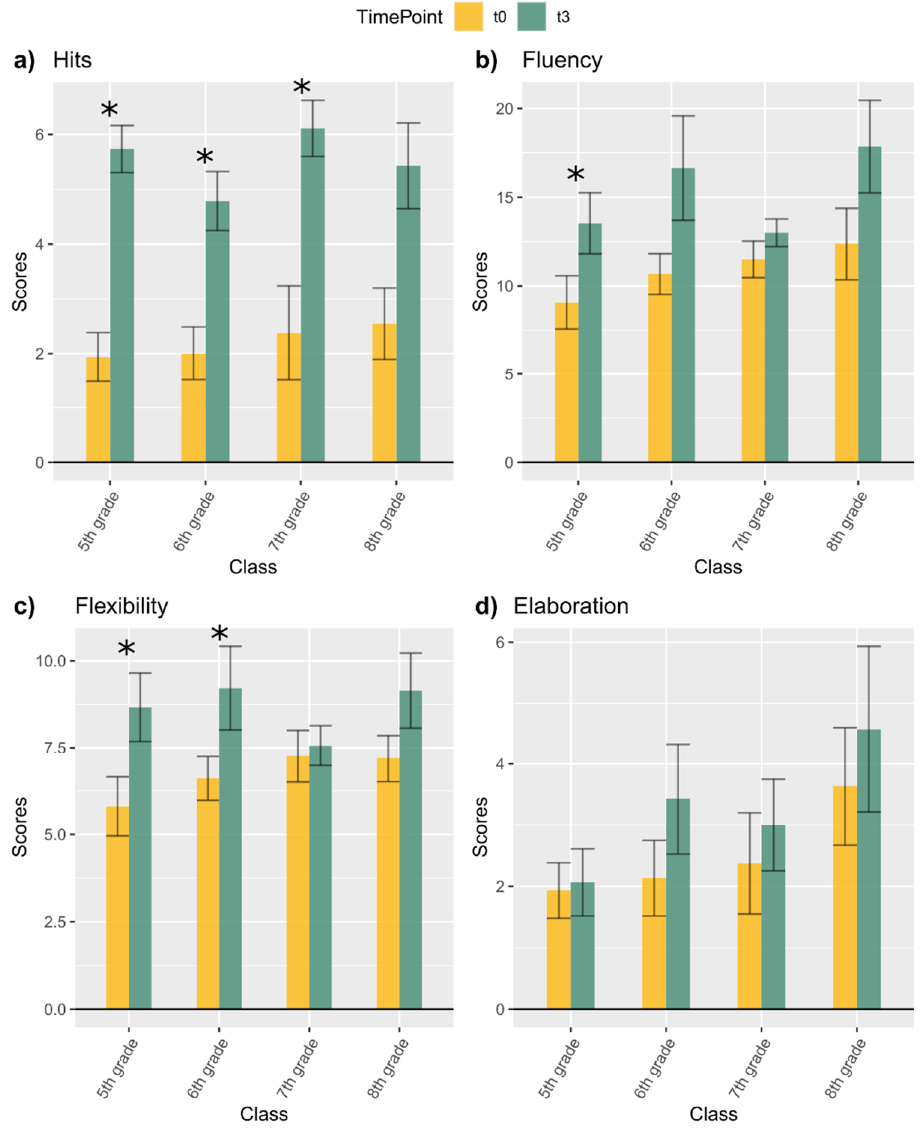
Figure 4. Comparisons between the baseline of the first training (t0) and the baseline before the second training (t3) for ( a ) Hits in HFT; ( b ) Fluency in AUT; ( c ) Flexibility in AUT; ( d ) Elaboration in AUT. Significance levels: * = p < 0.0125 (Bonferroni corrected alpha).